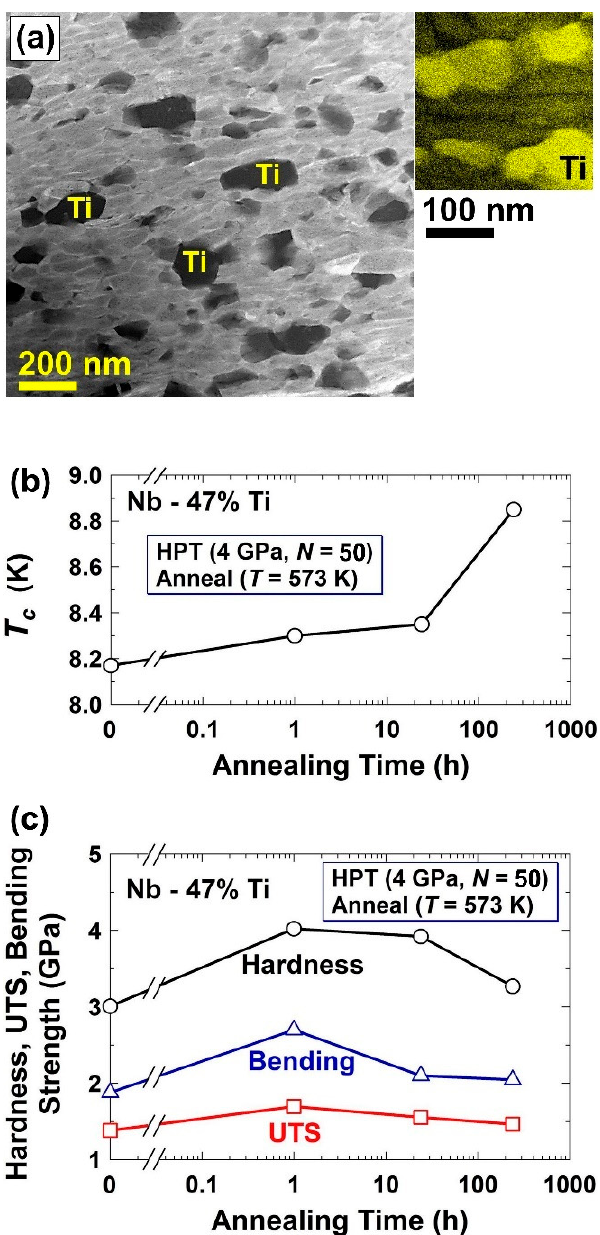
Figure 6. Synthesis of superconductors with high strength by ultra-SPD. ( a ) Microstructure of Nb-Ti synthesized by ultra-SPD followed by 10 days annealing at 573 K, examined by bright-field imaging ( left ) and elemental mapping ( right ) in scanning-transmission electron microscopy. ( b ) Critical temperature for superconductivity and ( c ) ultimate tensile strength, bending strength and hardness for Nb-Ti superconductor synthesized by ultra-SPD and annealed at 573 K for various periods of time [40].